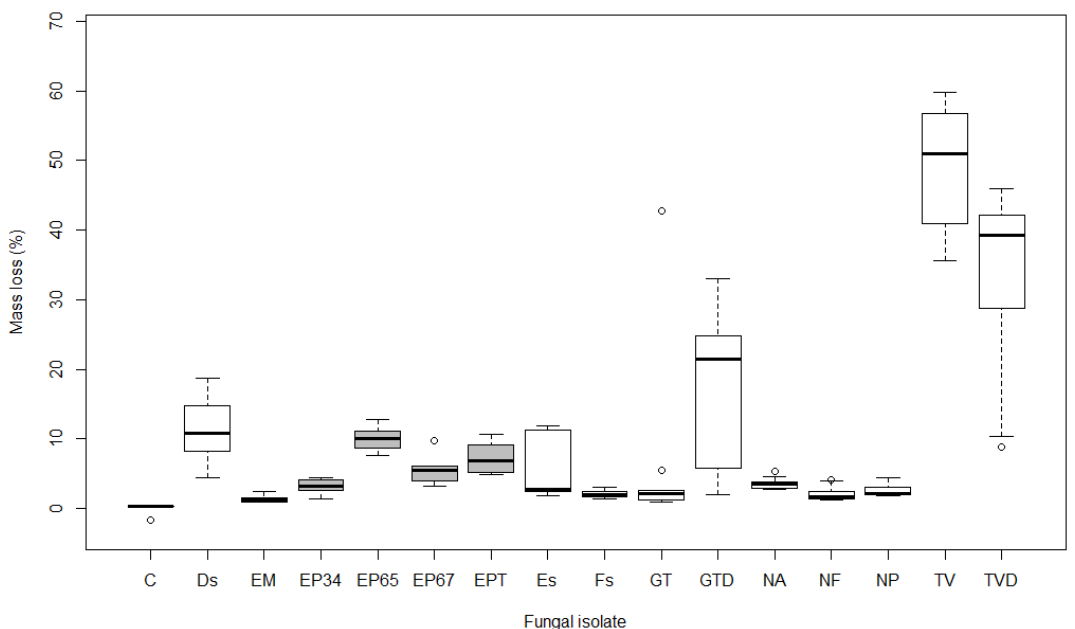
Figure 1. Boxplot showing mass loss (%) after 15 weeks of exposure to di ff erent fungal isolates in Acer pseudoplatanus (see Table 1 for labels of isolates; boxes of E. parasitica isolates are grey). Boxplot represents minimum, first quartile (Q 1 ), median, third quartile (Q 3 ), and maximum value. Di ff erences between average initial and final dry mass were significant for all isolates ( p < 0.05), except for the controls in all three maple species and GT isolate in A. pseudoplatanus